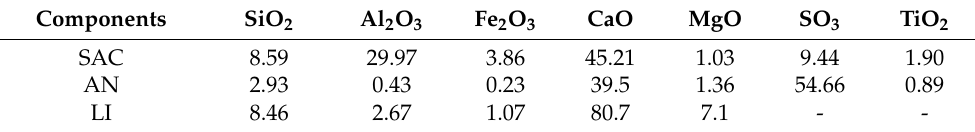
Table 2. The mineral composition of the sulfoaluminate cement clinker (wt%). C 4 A 3 S